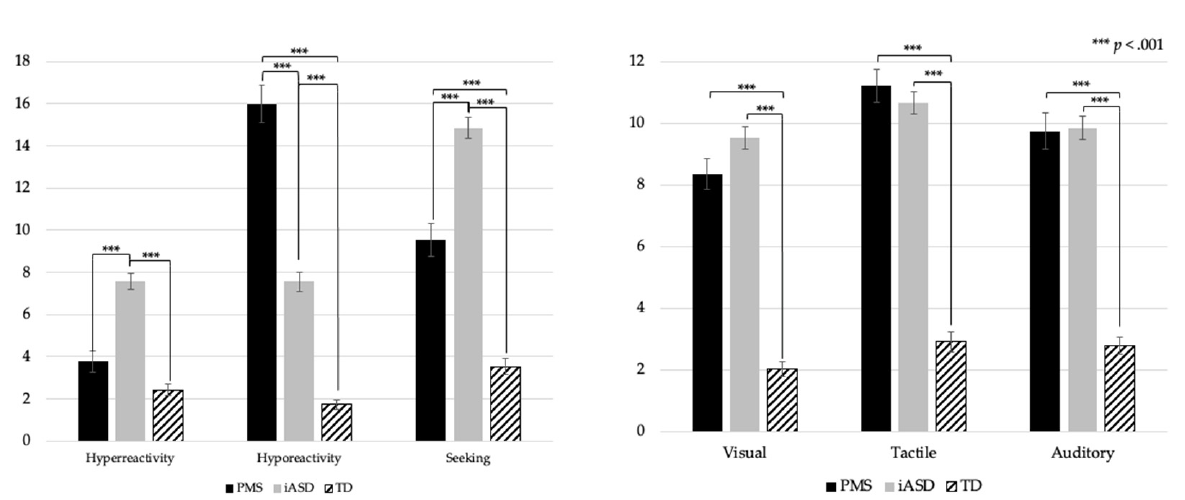
Table 3. Percentage of participants falling in the clinically significant range on the SAND.